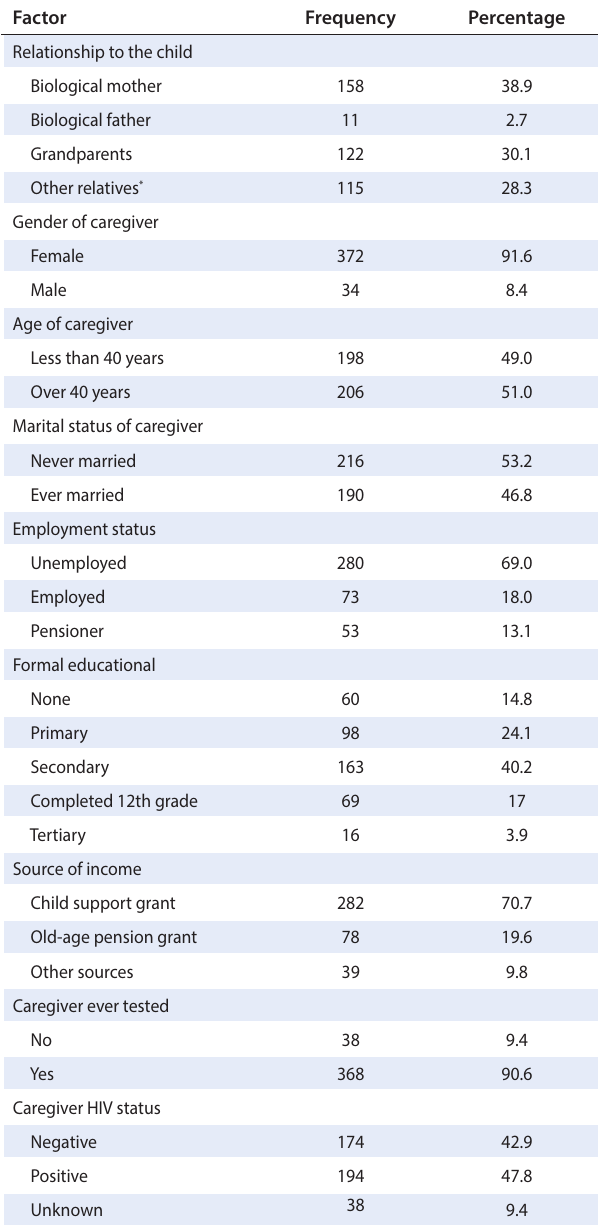
*Other relatives includes older sibling, uncles, and